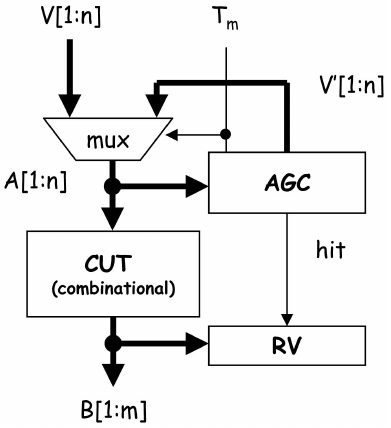
Figure 1. Input vector monitoring concurrent